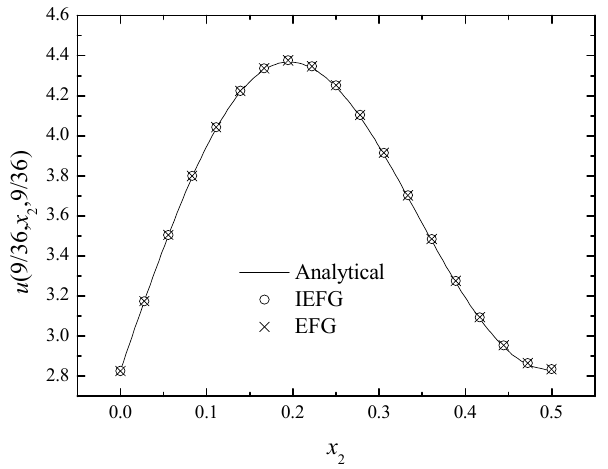
Figure 13. The comparison of numerical and exact solutions along x 2 -axis.